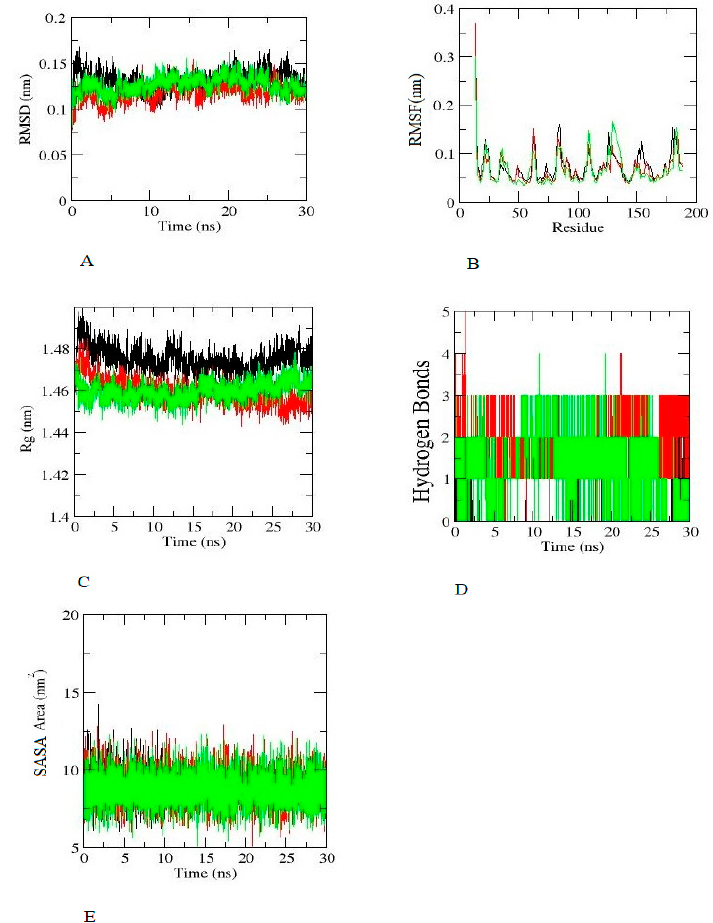
Figure 4. Molecular dynamics simulation of SHBG with hexaconazole (black colour), dihydrotestosterone (green colour), and aminoglutethimide (red colour). ( A ) RMSD and time ( B ) RMSF and residue ( C ) Rg and time ( D ) Hydrogen bond and time ( E ) SASA Area and time.